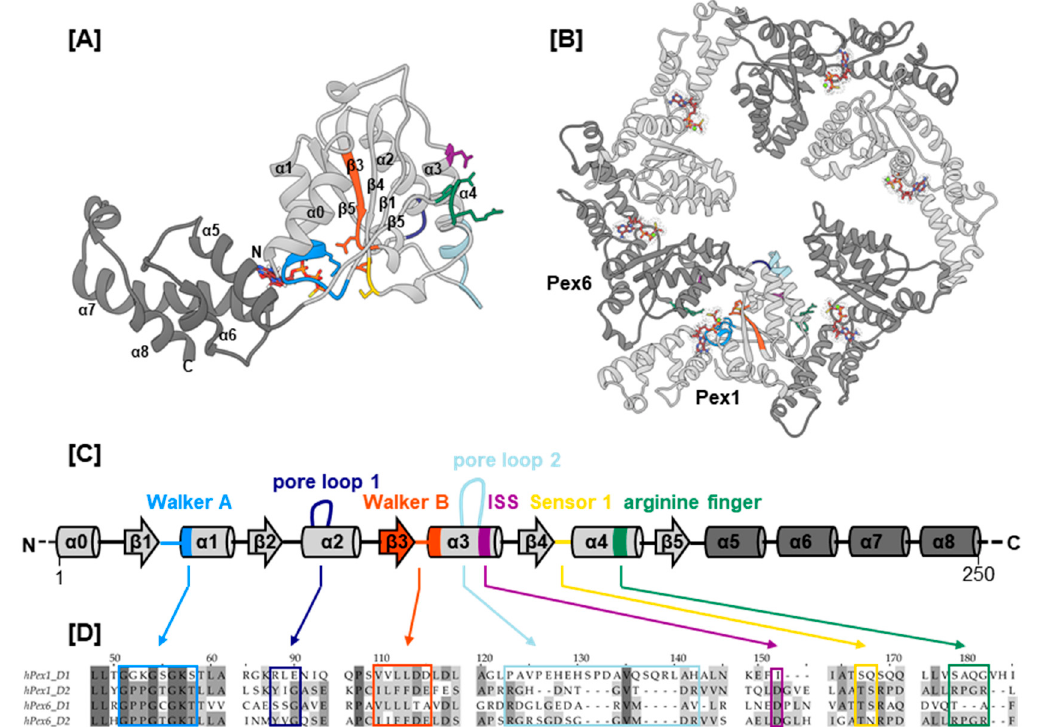
Figure 1. Structure and oligomeric arrangement of the D2 AAA+ ATPase domains. ( A ) Structure of the D2 domain of Pex1. The α / β -Rossmann fold is colored in light grey and the C-terminal α -helical subdomain in dark grey. Secondary structure elements are numbered in the order of appearance from N- to C-terminus, and conserved motifs are color coded. ( B ) Model of the hexameric assembly of the Pex1/Pex6 D2 AAA+ ring bound to ATP. Pex1 and Pex6 domains are colored in light and dark grey, respectively. ( C ) Secondary structure annotation of the Pex1 D2 domain shown in ( A ). ( D ) Sequences of canonical AAA+ elements in all Pex1/Pex6 ATPase domains color coded as shown in ( A ) and ( C ). The nucleotide is shown as a stick and surface representation in all monomers.